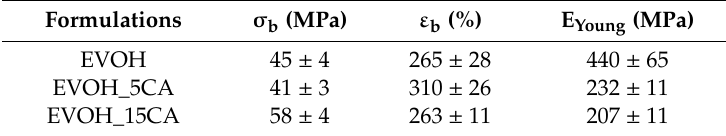
Table 3. Mechanical properties of EVOH based